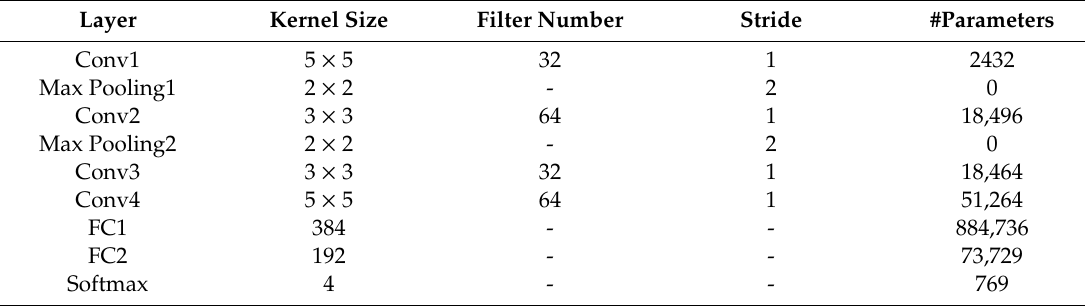
Figure 5. Structure of the proposed improved CNN. Table 2. Details concerning proposed CNN